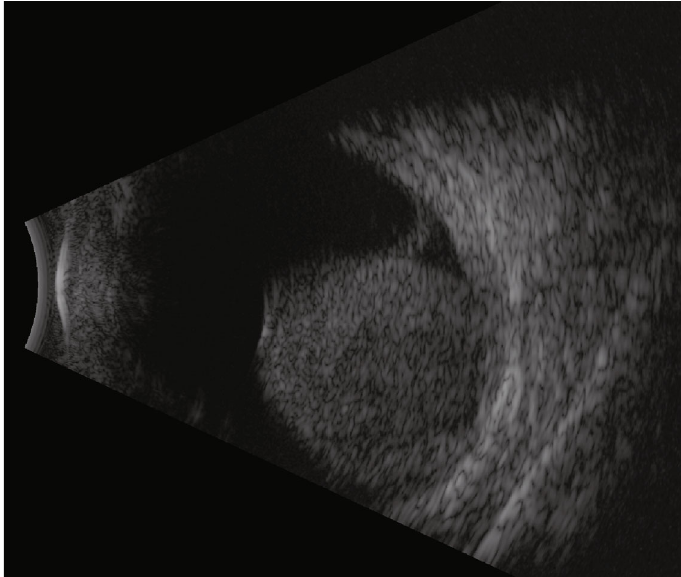
Figure 2: B-scan ultrasonography: large choroidal dome-shaped mass, with neither acoustic hollowing nor calci fi cation, associated with a retinal detachment (subretinal fl uid around the mass, without RD extending to the periphery).